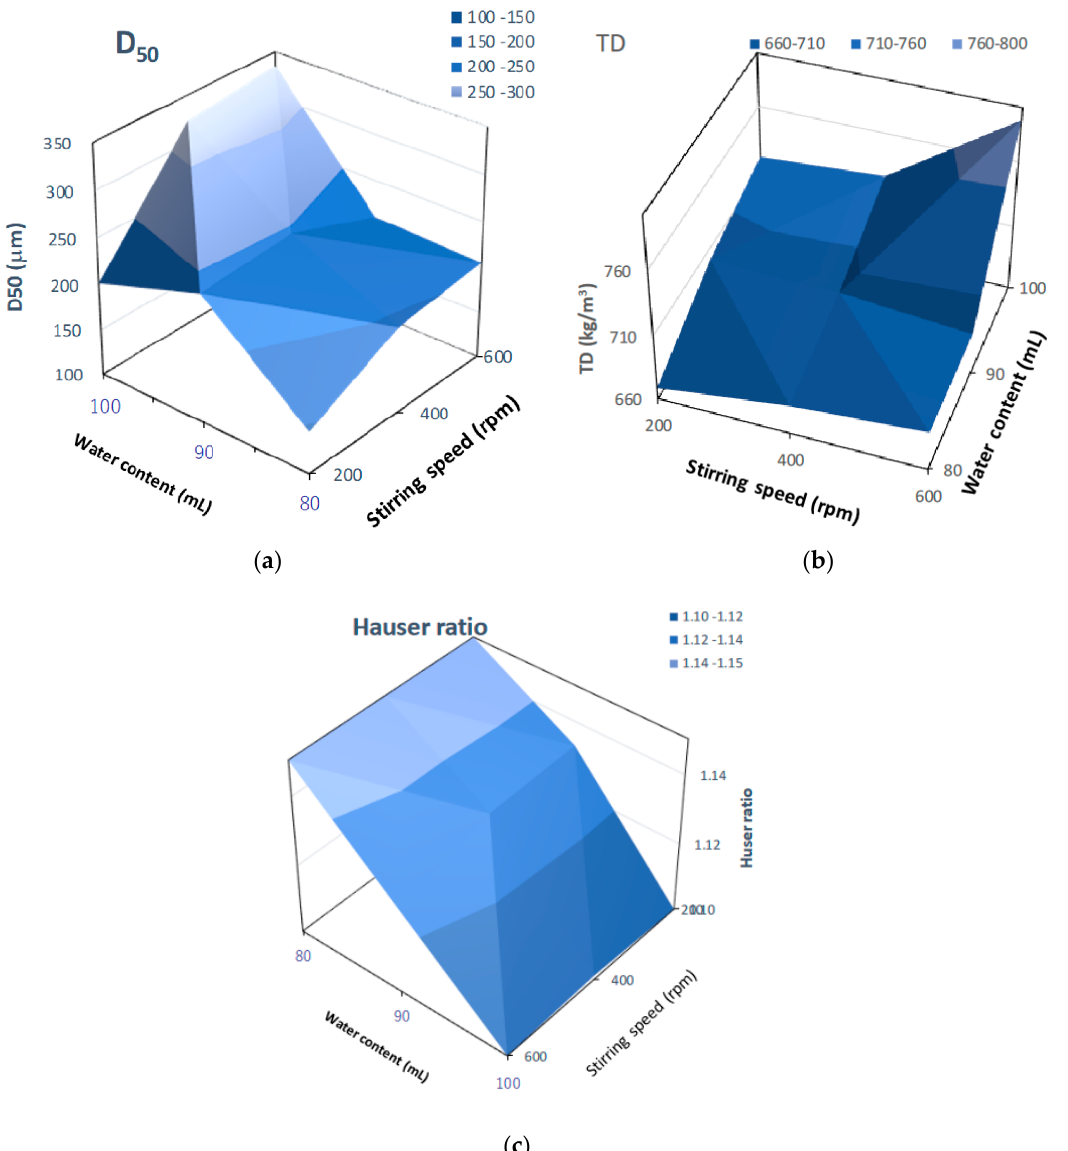
Figure 14. Three-dimensional plots of pharmaceutical properties of the final HSWG products pre- dicted using the NIR/PLSR method versus their critical process parameters. ( a ) D50; ( b ) TD; ( c ) HR.